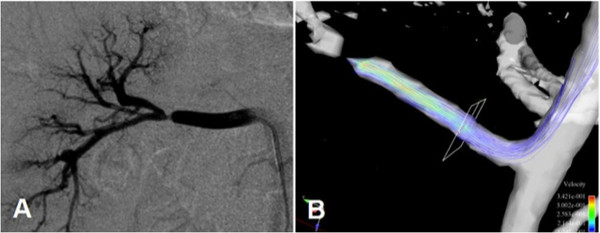
This figure illustrates one of the disadvantages of the 7D flow technique: if the trans-stenotic pressure gradient (TSPG) exceeds > 60 mmHg, as is the case in severe, high-grade stenoses, there is often no signal distal to the severe stenosis detected, rendering measurements of TSPG impossible. Courtesy of PD Dr. Bley, UKE Hamburg.